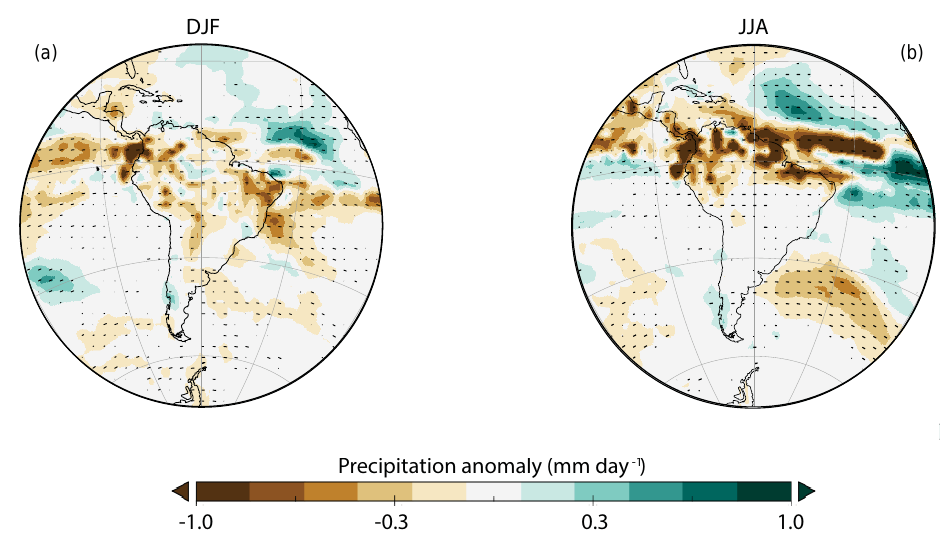
Figure 8. Last millennium post-volcanic precipitation composite (mmday − 1 ) with all eruption events during (a) DJF and (b) JJA from GISS ModelE2-R using procedure described in the text. Stippling highlights areas with anomalies significant at p< 0 .